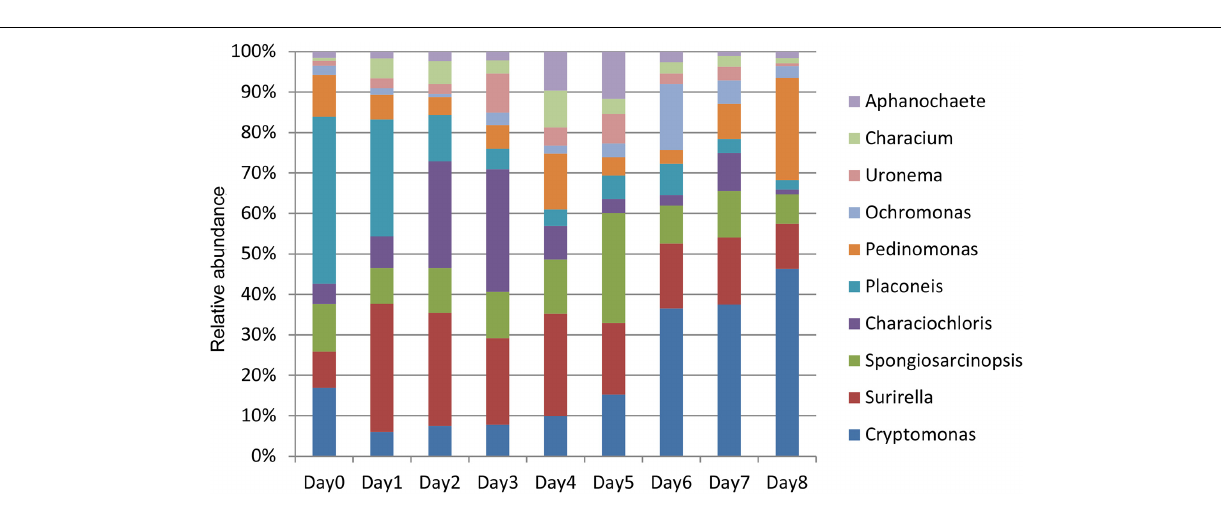
FIGURE 6 | Histogram of relative abundance of algae in the water around carcass at the genus